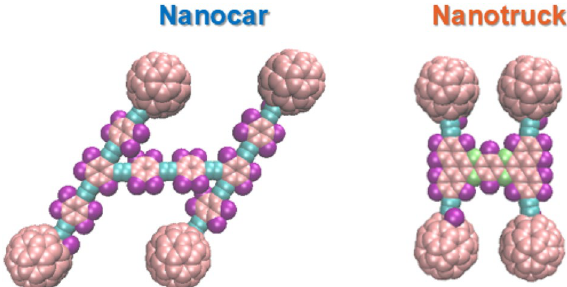
Figure 1. Atomic structure of Nanocar with Flexible chassis, size of 3 × 4 nm 2 , and 3 atom types (left side); and Nanotruck with Rigid chassis, size of 2 × 3 nm 2 , and 4 atom types (right side). Color codes: tan—sp2 and sp3 carbon, (C); teal—sp carbon (C); purple—hydrogen (H); green—nitrogen (N). The structures are visualized by VMD 44 .